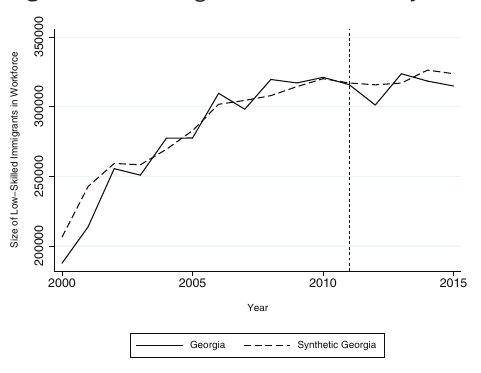
Georgia universal e-verify and size of low-skilled immigrant